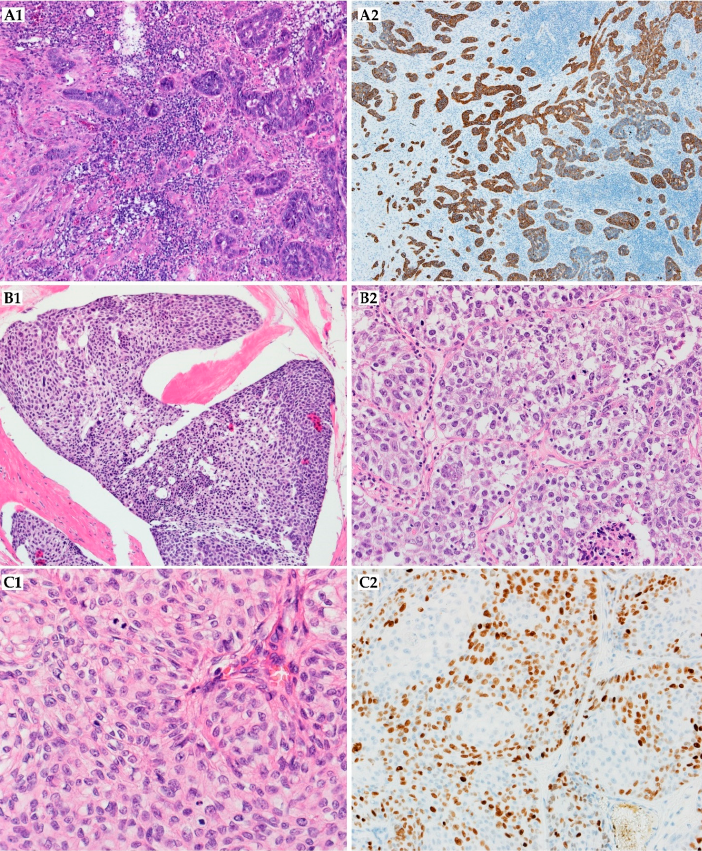
Figure 4. Malignant tumors with apocrine or eccrine differentiation I. ( A1 ) (20×, HE) and ( A2 ) (20×, CK7): adnexal adenocarcinoma, not otherwise specified, deeply invasive lesion, involves deep dermis and extends to subcutaneous tissues. ( B1 ) (40×, HE) and ( B2 ): Porocarcinoma characterized by infiltrative borders, and atypical cytological features, increased mitotic activity, and focal necrosis. ( C1 ) (400×, HE) and ( C2 ) (200×, Ki67): Hidradenocarcinoma, predominantly composed of bland, clear cells, with increased mitotic activity.